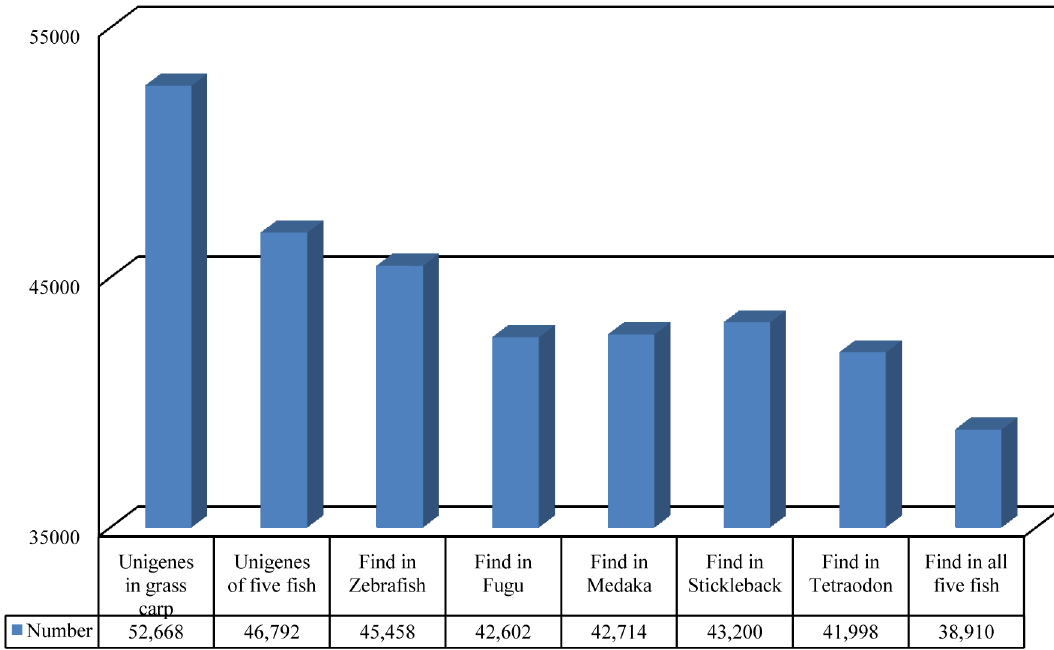
Fig 2. Genes conserved in C . idella and five model fish species (zebra fish, fugu, stickleback, medaka and Tetraodon ). BlastX was used to identify C . idella homologous genes with other fish species by searching public database.